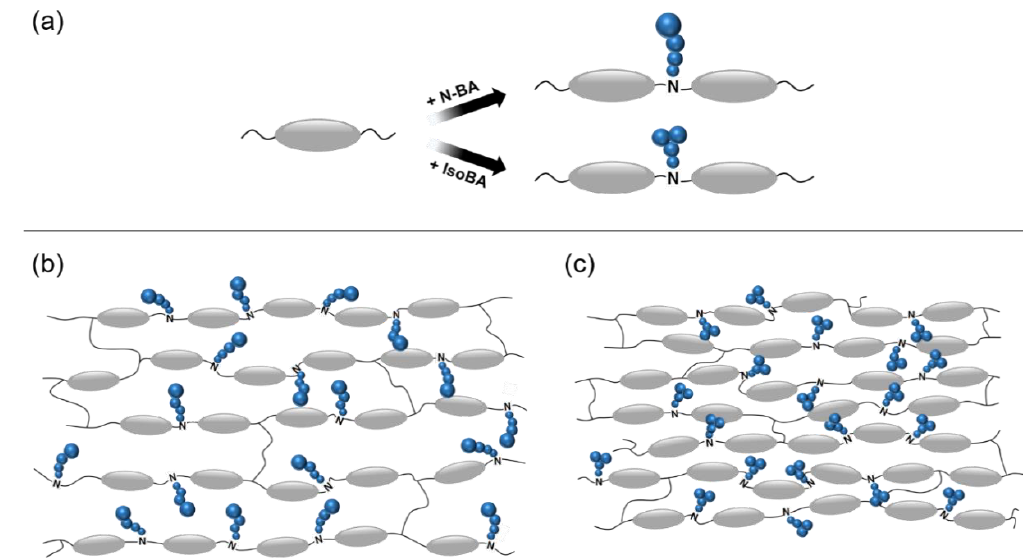
Figure 8. ( a ) Schematic of the diffusion model of side chains in the LCEs. The spheres (blue) represent individual carbon sites, and the ellipsoids (gray) represent the rod-like mesogens. Based on the diffusion model, the molecular packing structures of the ( b ) LCE containing n-butyl group and ( c ) LCE containing isobutyl group are suggested.